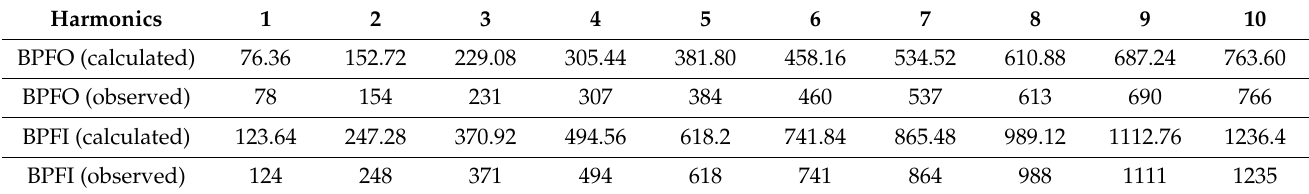
Table 4. Calculated bearing fault characteristic frequency harmonics for State 0.